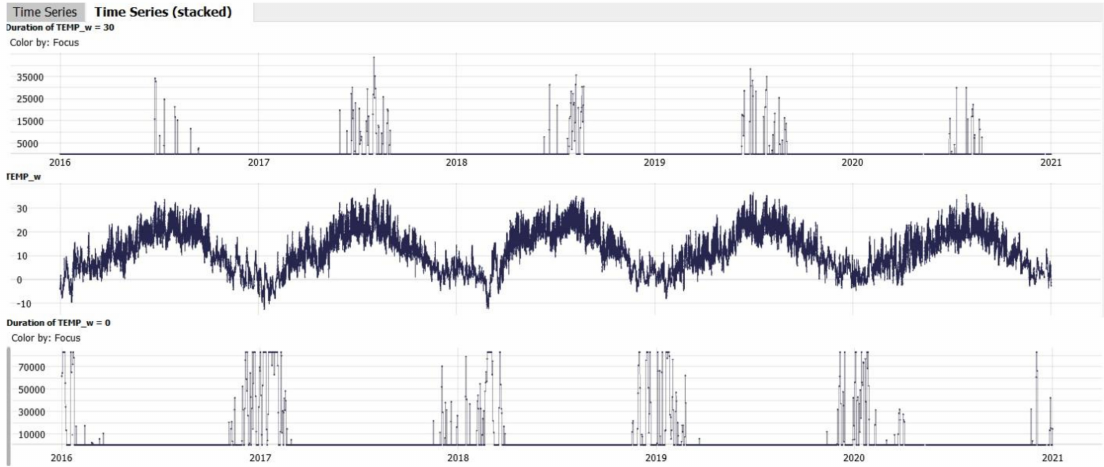
Figure 7. Annual distribution and diurnal duration (expressed in seconds) of temperature breaching a predefined threshold for Vienna: temperature maxima ( above ), temperature minima ( below ).